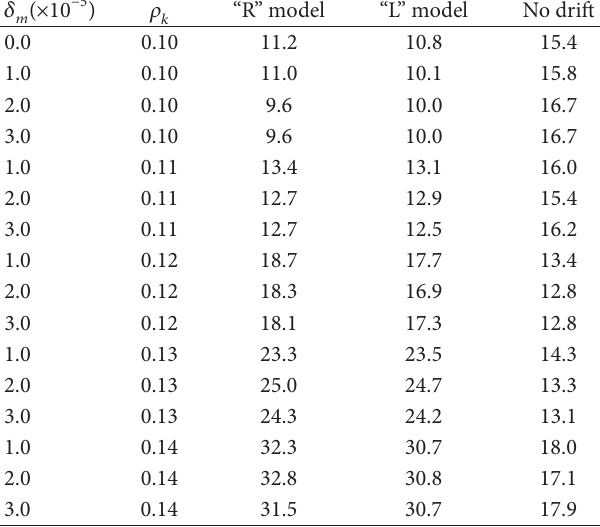
T 7: Average values (last three columns) of 2000, BESS-2002 obtained from (17) without enhancement of the diffusion tensor along the polar direction ( and “L” models for the tilt angle and No Dri approximation. e differential intensities were calculated accounting for particles inside the heliospheric regions for which solar latitudes are lower